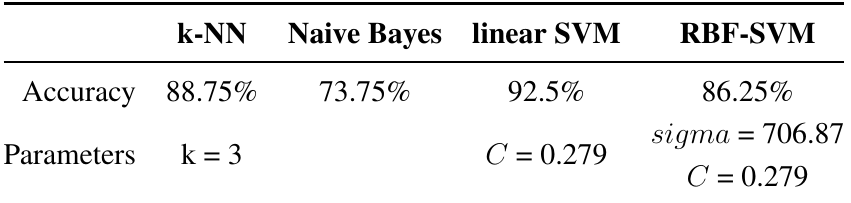
Table 3. Classification results from using 4 classifier models and the